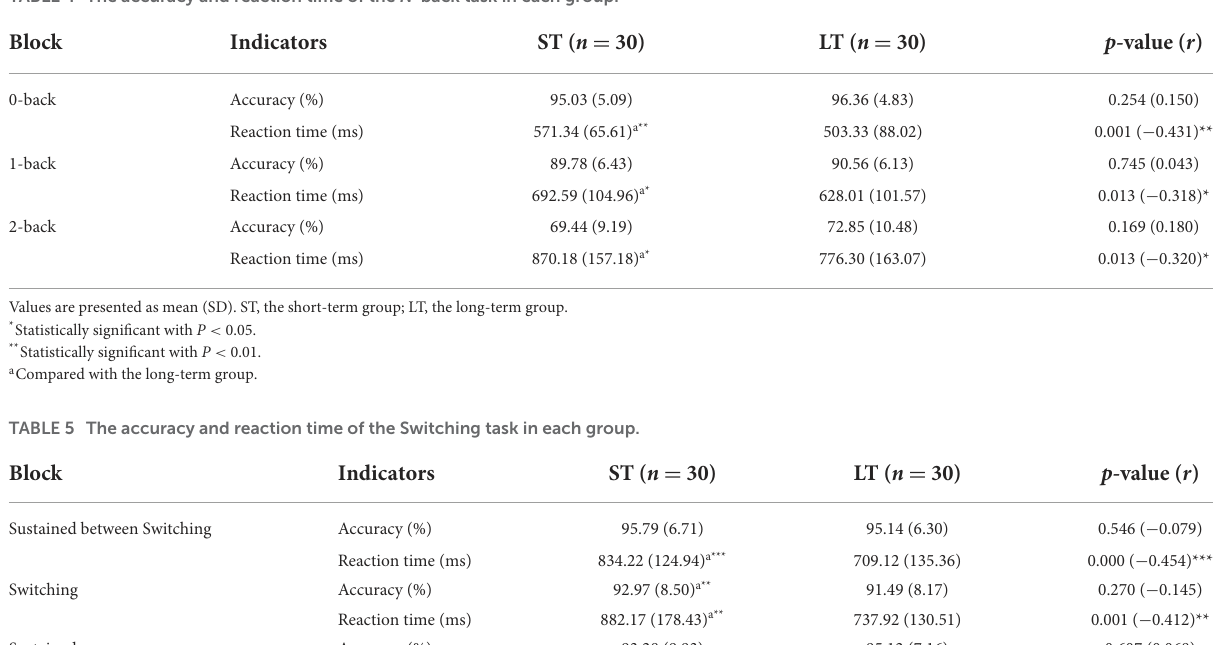
TABLE 4 The accuracy and reaction time of the N -back task in each group.